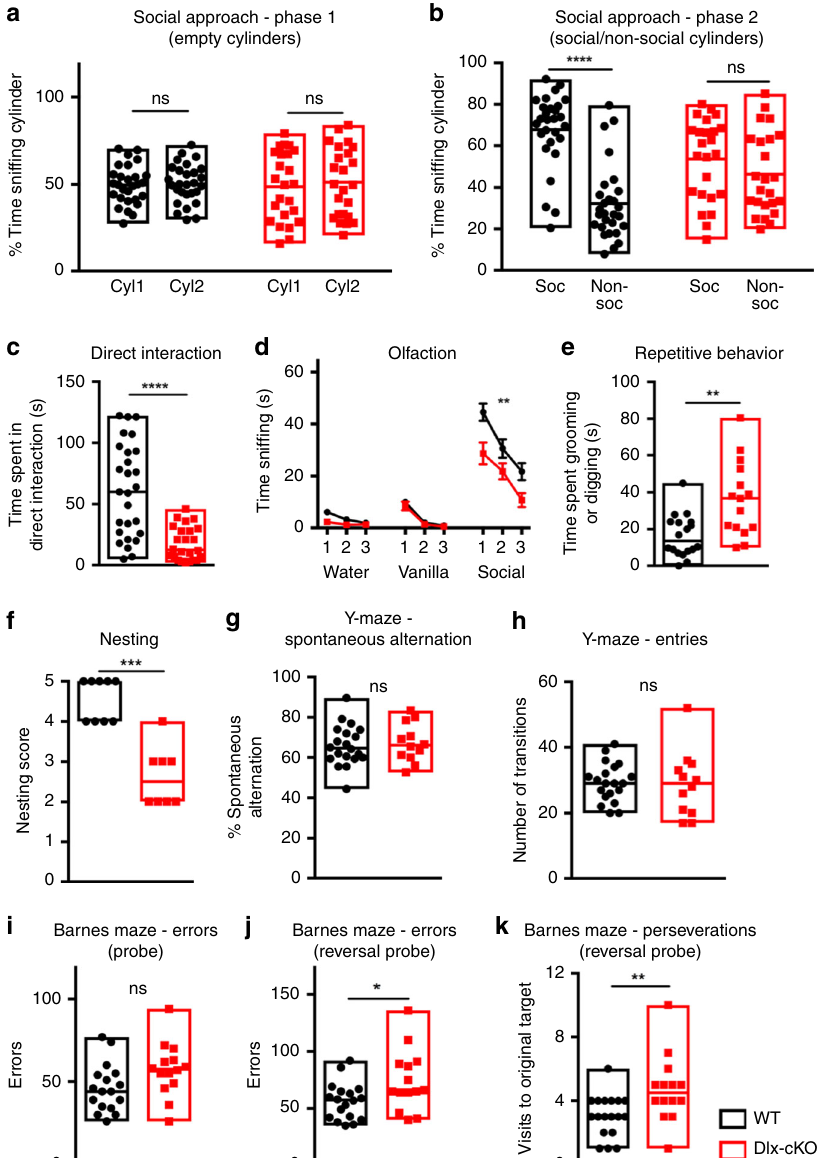
Fig. 1 Dlx-cKO mice exhibit an autistic-like phenotype. a Dlx-cKO mice showed similar times spent interacting with empty cylinders during the habituation phase of the three-chambered social assay. Cyl1/Cyl2: empty cylinders 1 and 2. Soc: social cylinder containing a stimulus mouse. Non-soc: nonsocial cylinder containing an object. (WT, n = 28; Dlx-cKO, n = 26; paired t -test). b Wild-type mice showed a signi fi cant preference for interacting with the cylinder containing a social stimulus, but Dlx-cKO mice did not show a signi fi cant difference in time spent snif fi ng the social and nonsocial cylinders (paired t -test). c Dlx-cKO mice also spent signi fi cantly reduced time initiating social contact during the direct interaction phase (unpaired t -test). d Dlx-cKO mice showed unaltered ability to discriminate between odors and habituation to the same odor upon repeated presentation. However, Dlx-cKO mice show a reduced time snif fi ng a social scent compared to WT (WT, n = 20; Dlx-cKO, n = 14; two-way ANOVA with Holm-Sidak ’ s multiple comparisons test; error bars demonstrate s.e.m.). e Dlx-cKO mice spent signi fi cantly more time engaging in repetitive behaviors, including grooming and digging, within a 10-min period in a home-cage like environment (WT, n = 18; Dlx-cKO, n = 16; unpaired t -test). f Dlx-cKO mice show signi fi cantly reduced nesting scores on the nesting assay (WT, n = 9; Dlx-cKO, n = 8; Mann – Whitney test). g Dlx-cKO mice show unaltered spontaneous alternation percentage in comparison to WT mice (WT, n = 20; Dlx-cKO: n = 12; unpaired t -test). h The total number of entries made were not signi fi cantly different between Dlx-cKO and WT mice (unpaired t -test). i Dlx-cKO mice did not show a signi fi cant difference in the total number of errors made on forward probe trials of the Barnes maze (WT, n = 18; Dlx-cKO: n = 14; unpaired t -test). j Dlx-cKO mice made signi fi cantly more errors on the reversal probe trials of the Barnes maze (unpaired t